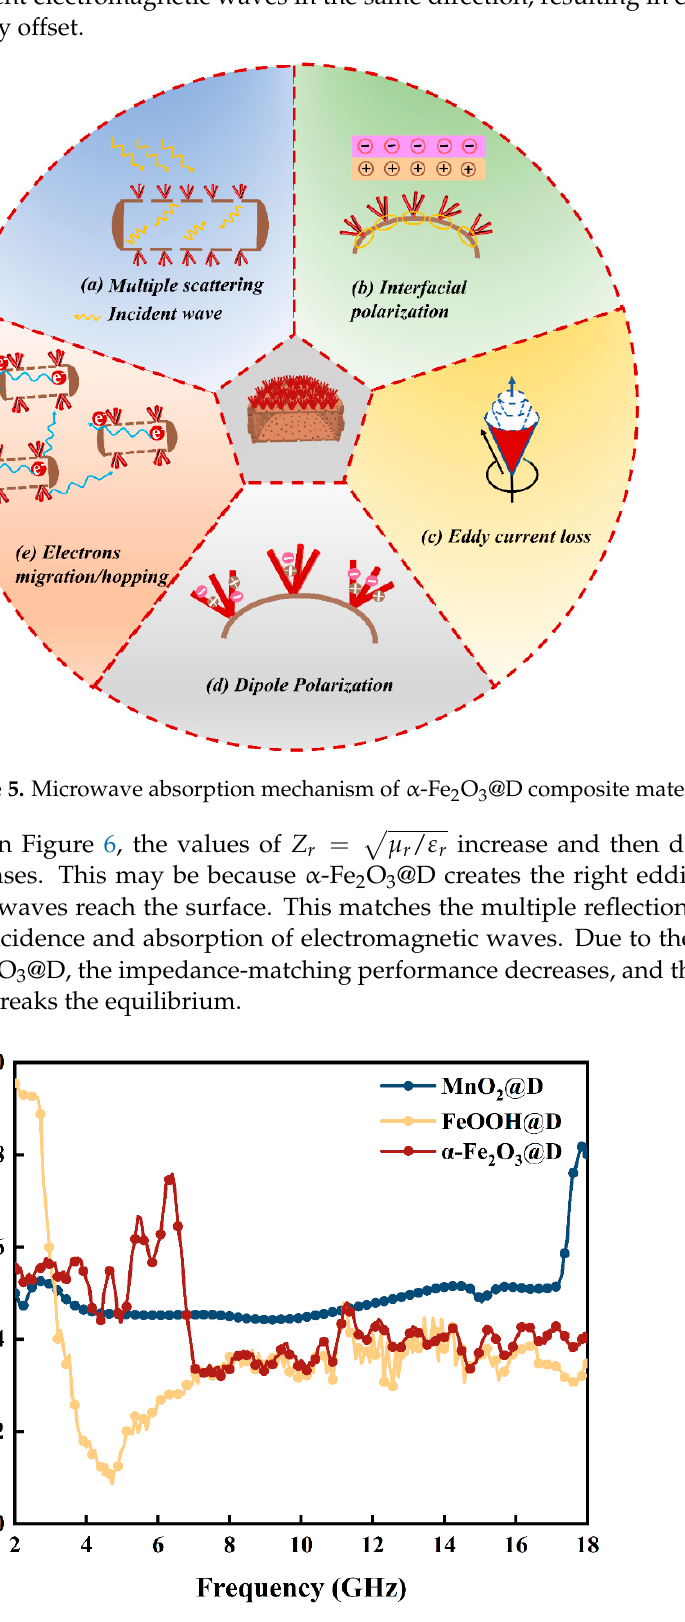
Figure 6. Frequency dependence of impedance matching Zr of the MnO 2 @D, FeOOH@D and α -Fe 2 O 3 @D composite material.